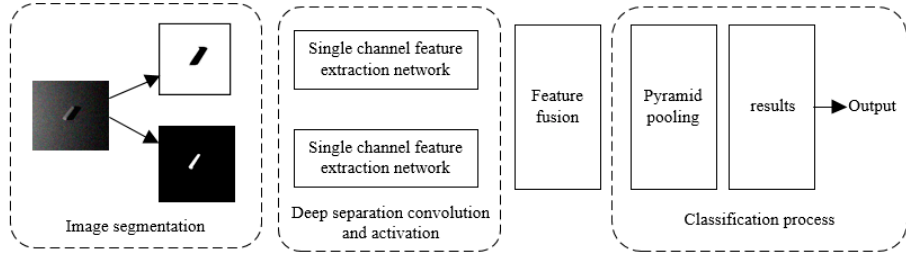
Figure 1. Joint classification system of highlight and shadow of small objects in underwater sonar